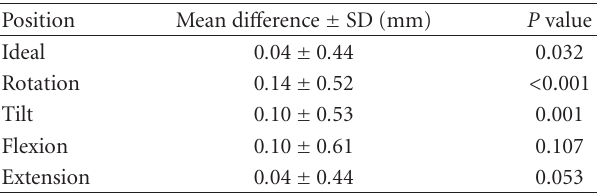
Table 2: Mean di ff erence between physical measurements and radiographic measurements in di ff erent positions.